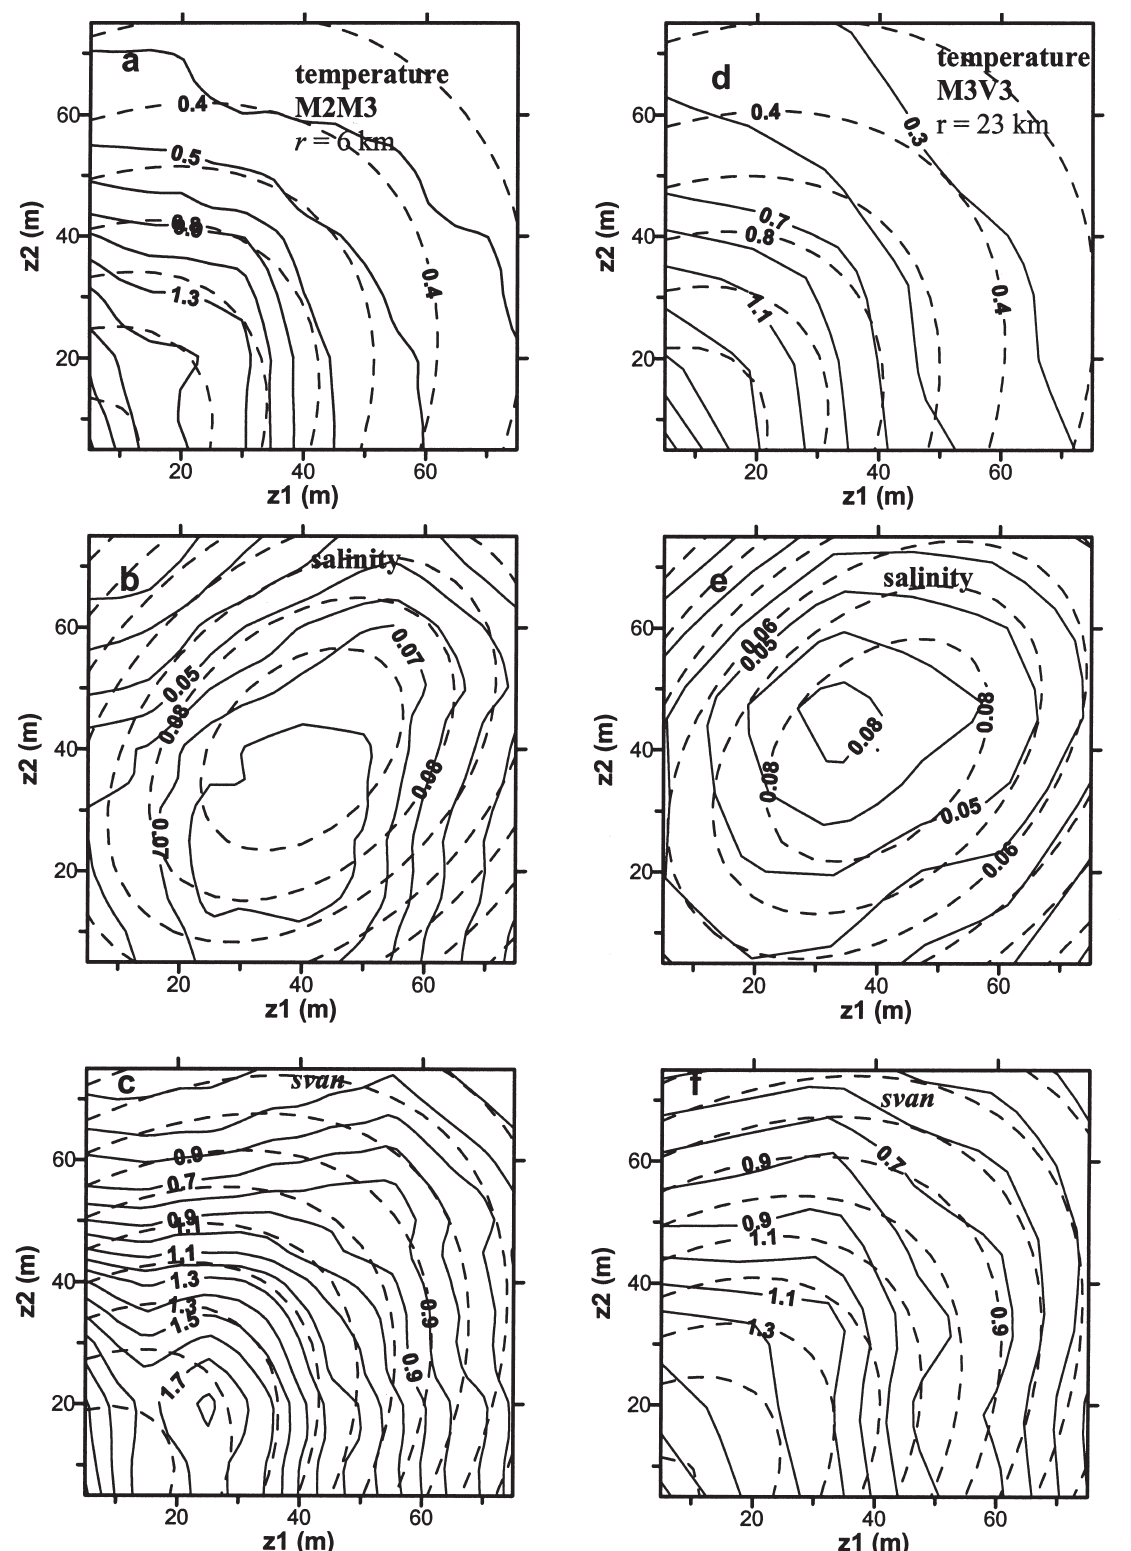
F IG . 7. – Isolines of constant covariance (solid line) for pairs of points with different vertical and horizontal coordinates (a, b, c correspond to stations M2 and M3, r=6 km and Figures d, e, f to M3, V3). Dashed lines correspond to the theoretical values predicted by the expression (2, Section 4.4) and parameters in Tables 1 and